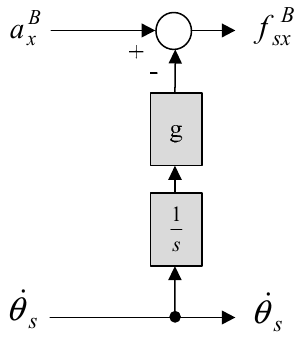
Figure 4. The model of the simulator.